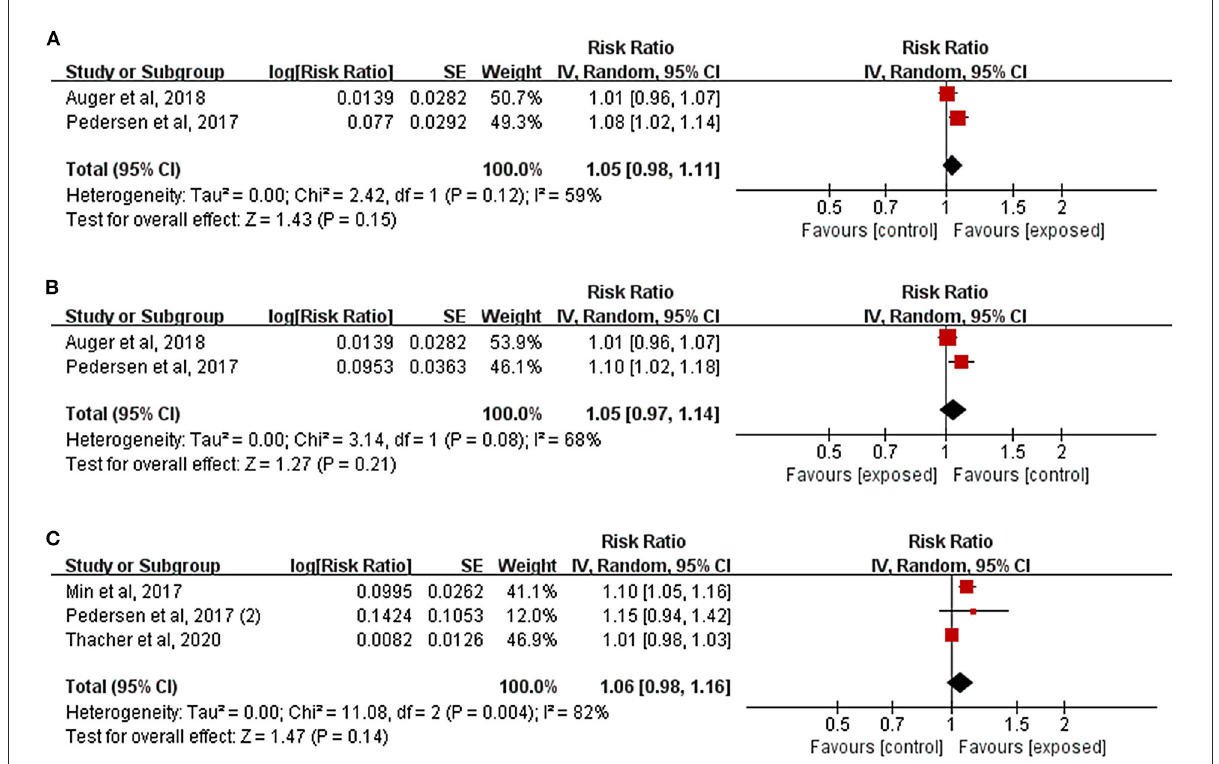
FIGURE4 Forest plots for the relationship between residential noise exposure and pregnancy complications. Tau 2 , Chi 2 , and df are the statistics in the heterogeneity test, and I 2 is the effect variable attributable to heterogeneity. Z -value is the statistical variable of the overall effect, and inverse variance (IV) is the effect estimation of the study. Effect sizes are given by 95% confidence intervals (95% CI ). The weights are determined by random effects analysis. The size of the boxes around the points reflects the weight assigned to each study. (A) Hypertensive disorders of pregnancy; (B) Preeclampsia; (C) Gestational diabetes